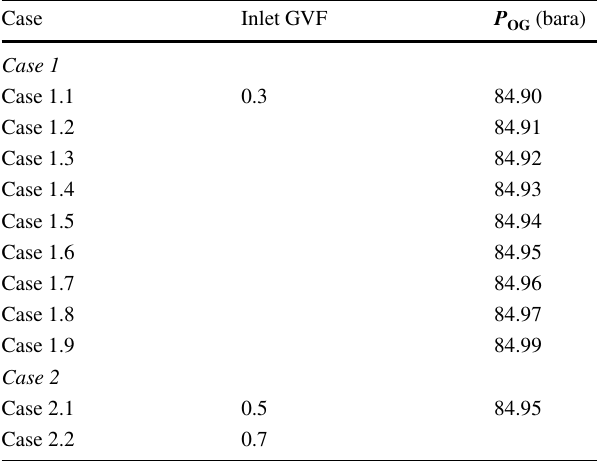
Table 3 Simulation plan for performance evaluation